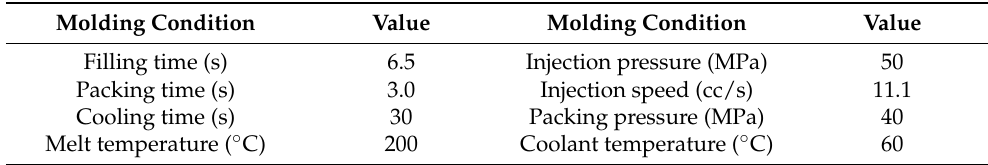
Table 3. Injection molding conditions for numerical